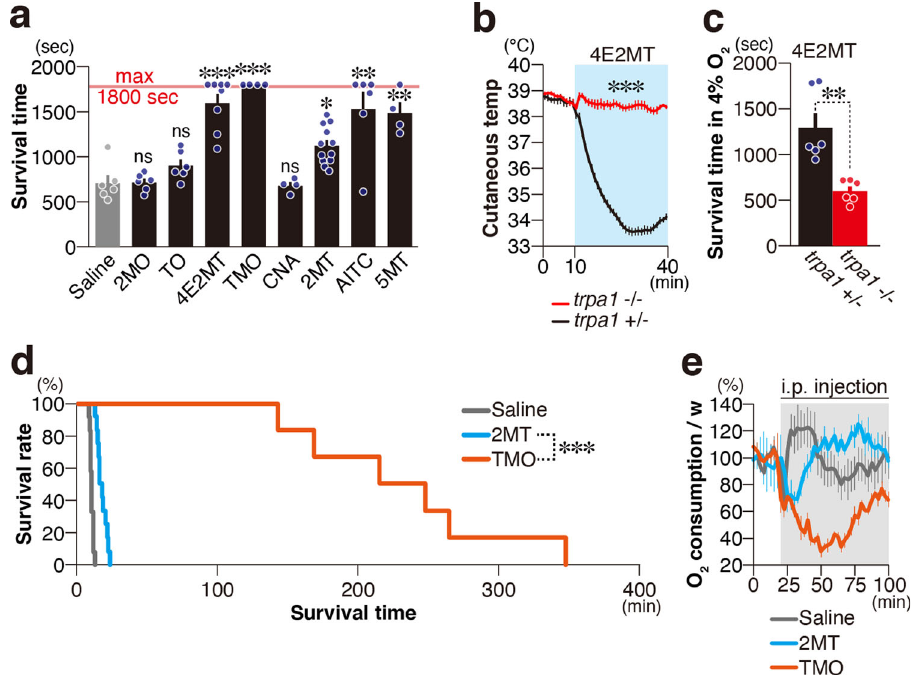
Fig. 10 Identi fi cation of novel compounds with ultrapotent anti-hypoxic activities. a Mean survival time in 4% oxygen in response to IP administration of the indicated compounds are shown ( n = 6 for saline, 2MT, TO, and AITC; n = 8 for 4E2MT; n = 4 for TMO, CNA, and 5MT; and n = 12 for 2MT; p = 0.8728 for 2MO, p = 0.2701 for TO, p = 0.0001 for 4E2MT and TMO, p = 0.9493 for CNA; p = 0.0182 for 2MT; p = 0.0015 for AITC; and p = 0.0036 for 5MT, on Kruskal – Wallis with uncorrected Dunn ’ s test). b Temporal analysis of cutaneous temperature in Trpa1 − / − (red) and control (black) mice in response to IP administration of 4E2MT are shown ( n = 6 for each genotype). Statistical signi fi cance was assessed for cutaneous temperature after IP administration of 4E2MT (11 – 40 min; p < 0.0001, Student ’ s t test, unpaired, one-tailed). c Mean survival time in 4% oxygen in Trpa1 − / − (red) and control (black) mice in response to IP administration of 4E2MT ( n = 6 for each genotype, p = 0.0011, one-tailed Mann – Whitney U test). d Survival rate in 4% oxygen with prior IP administration of saline (gray; n = 6), 2MT (blue; n = 12), and TMO (orange; n = 6). e Temporal analysis of oxygen consumption in response to IP administration of saline (gray), 2MT (blue), and TMO (orange) ( n = 4 for each condition). Data are shown as mean ± SEM; * p < 0.05; ** p < 0.01; *** p <